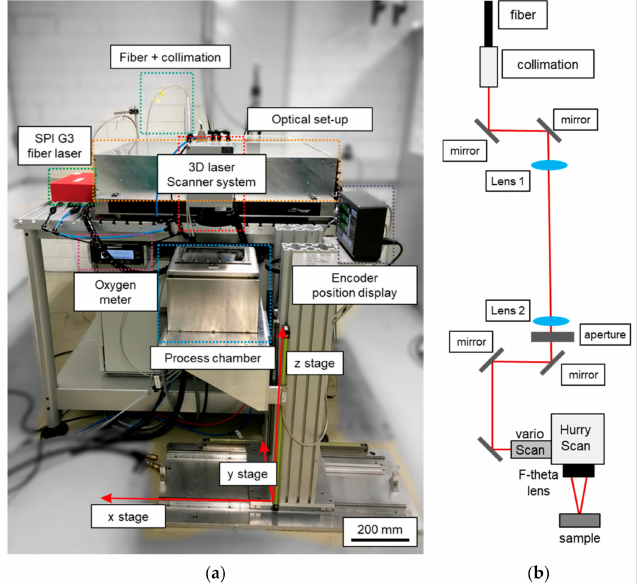
Figure 1. ( a ) Experimental setup, and ( b ) schematic of laser beam path and optical elements. This laser beam source emits multimodal laser radiation typically at a beam quality of M 2 = 2.8–3.6. In this study, laser radiation was used in continuous wave (cw) mode with a maximum laser output power of approx. P L = 36 W at the workpiece surface. The laser beam was coupled into the optical setup (breadboard + optical elements) via an optical fiber and collimation with a collimated raw beam diameter of r Laser = 5.5 mm. Using various combinations of fused silica lenses and f-theta objectives, enables a wide range of different laser beam diameters on the workpiece for laser processing. In this setup, the lenses were used as a relay system in an 1:1 imaging configuration and an f-theta objective with a focal length of f T = 163 mm (Figure 1b) was used for focusing the laser beam. Laser processing took place in a process chamber, in which particularly the oxygen content was monitored and controlled. The resulting laser beam caustic and intensity distribution in the focal plane were measured for this investigation (Figure